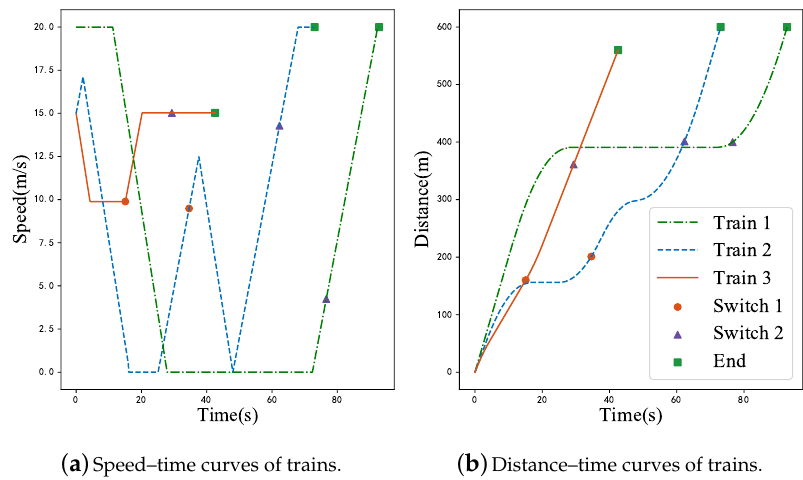
( a ) Speed–time curves of trains. ( b ) Distance–time curves of trains. Figure 3. Trains operation curves of naive strategy 1 in scenario 1.